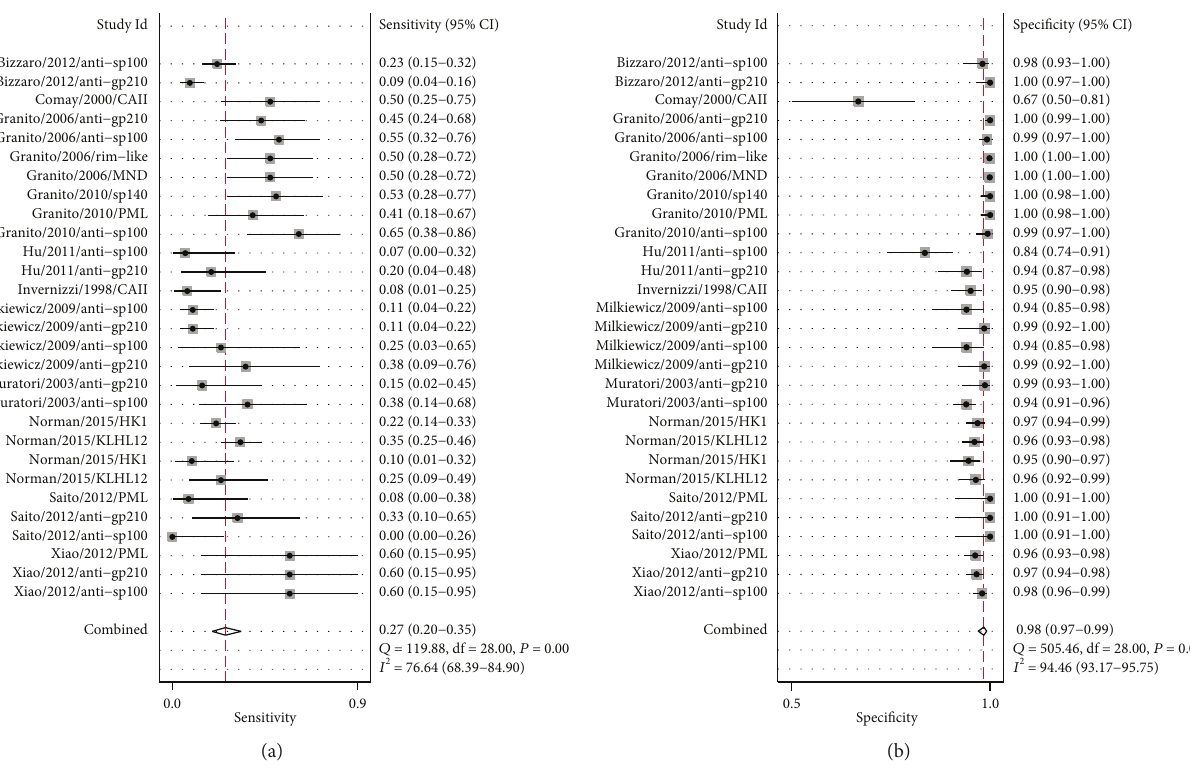
Figure 3: Forest plot of the sensitivity and speci fi city of ANAs for the diagnosis of AMA-negative PBC. In order to distinguish di ff erent ANAs, we listed both the author name with publication years and the di ff erent categories of ANAs. That will lead to one study with more than one forest plot in Figure 3. The fi rst author, published years, and types of ANAs are shown together with sensitivities, speci fi cities, and 95% con fi dence interval. Combined sensitivities and speci fi cities are also shown with the results of the Q test and the I 2